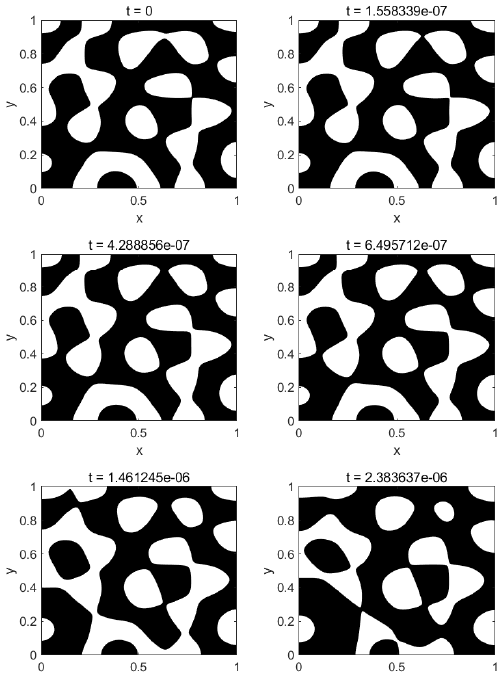
Figure 6. Patterns formed during the phase separation phenomena for the case where D = 10 5 , c o* = 0.2 and T * = 0.29 at x * = 0 and T 2* = 0.30 at x * = 1. The asterisks were left out of the variables x , y , and t in the figure. ChemEngineering 2019 , 3 , x FOR PEER REVIEW